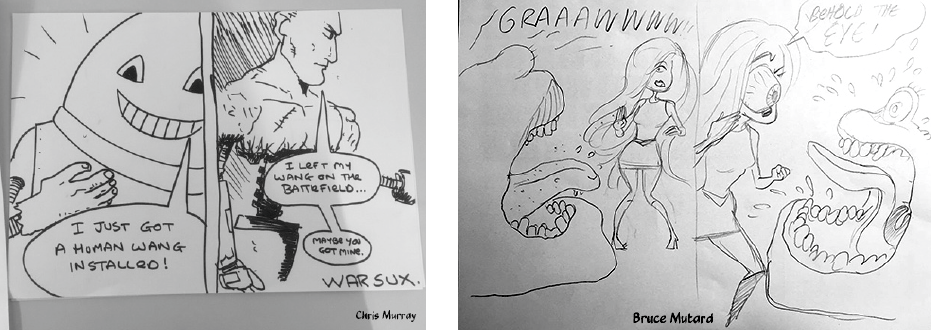
Figure 12. Samples of participant work from the science-fiction character design